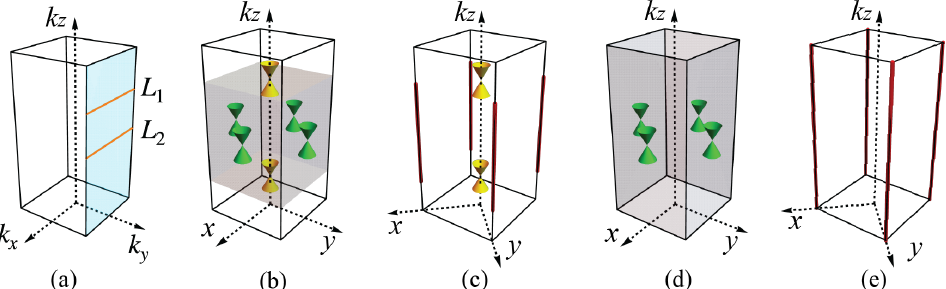
FIG. 5. (a) shows the first Brillouin zone corresponding to the 3D lattice respecting the P 4 =nmm symmetry group. L 1 and L 2 (orange) π plane (cyan). (b) – (e) illustrate different topological superconductor phases in the system. (b) and (c) sketch are two lines in the k y ¼ ; π ; k 0 and its the second-order topological Dirac superconductor phase. In this phase, there are Dirac nodes (yellow) in the bulk at ð k 0 x z Þ π for symmetry-related points. On the (100) surface shown in (b), there are 2 Z Dirac cones (green) dispersing flatly along the line k y ¼ 1¯1 j k z j < k 0 z (the gray region); and at the hinges between the (11) and ð Þ surfaces shown in (c), there are Z Majorana pairs (red) < k 0 dispersing flatly along the k direction for j k . (d) and (e) sketch the full-gap second-order topological superconductor phase. In z z z j π line on the (100) surface shown this condition, 2 Z Dirac cones (green) disperse flatly across the surface Brillouin zone along the k y ¼ 1¯1 in (d); and Z Majorana pairs (red) disperse flatly across the 1D Brillouin zone at the hinges between the (11) and ð Þ surfaces shown in (e). The modes on other edges and hinges can be obtained by symmetry and are also indicated in (b) – (e).